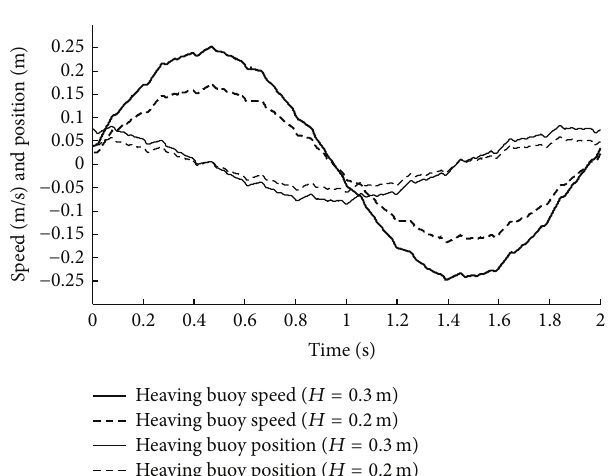
Figure 4: Position and speed of the heaving buoy in the vertical direction according to different wave height [ 𝐻 ]; the wave period is 2 s.